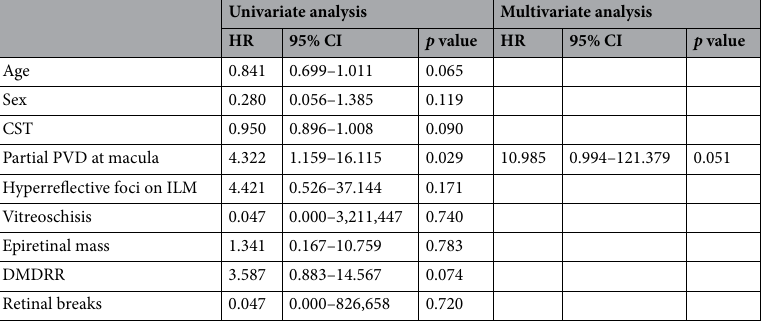
Univariate analysis Multivariate